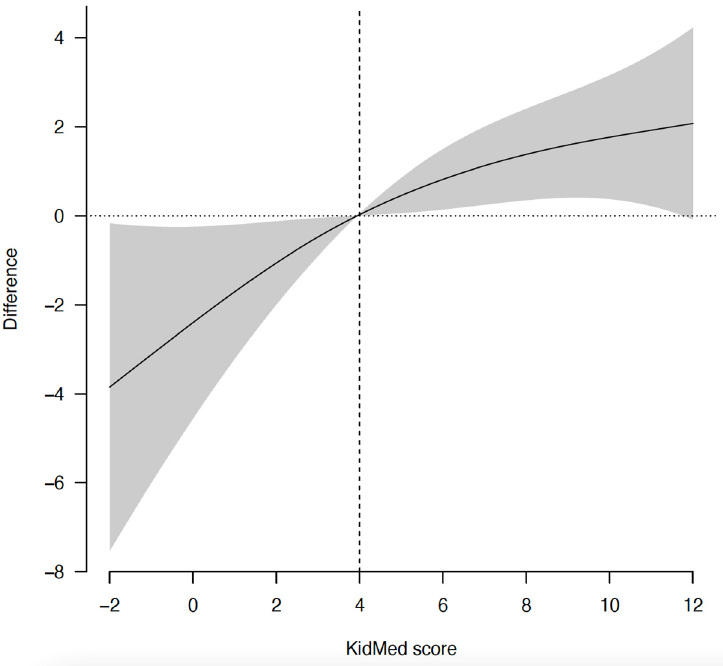
Figure 1. Dose response analysis between adherence to the Mediterranean diet and HRQoL. Reference value of the KidMed score was set to 4 units. Gray shadow= 95% confidence interval.